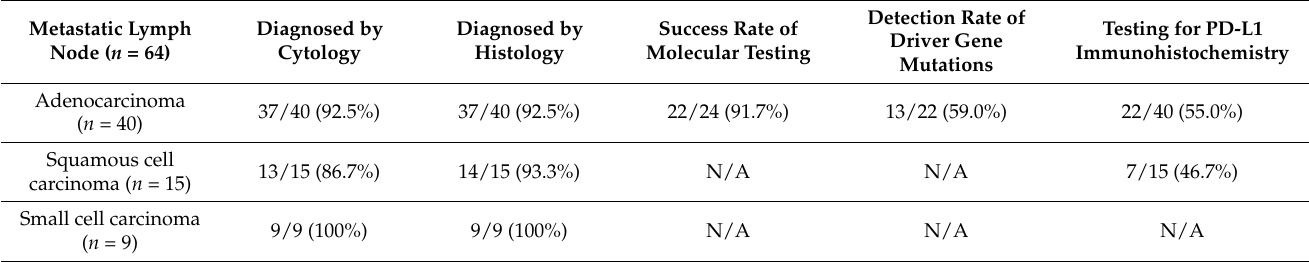
Table 2. Detailed results of pathological diagnosis and biomarker testing in this